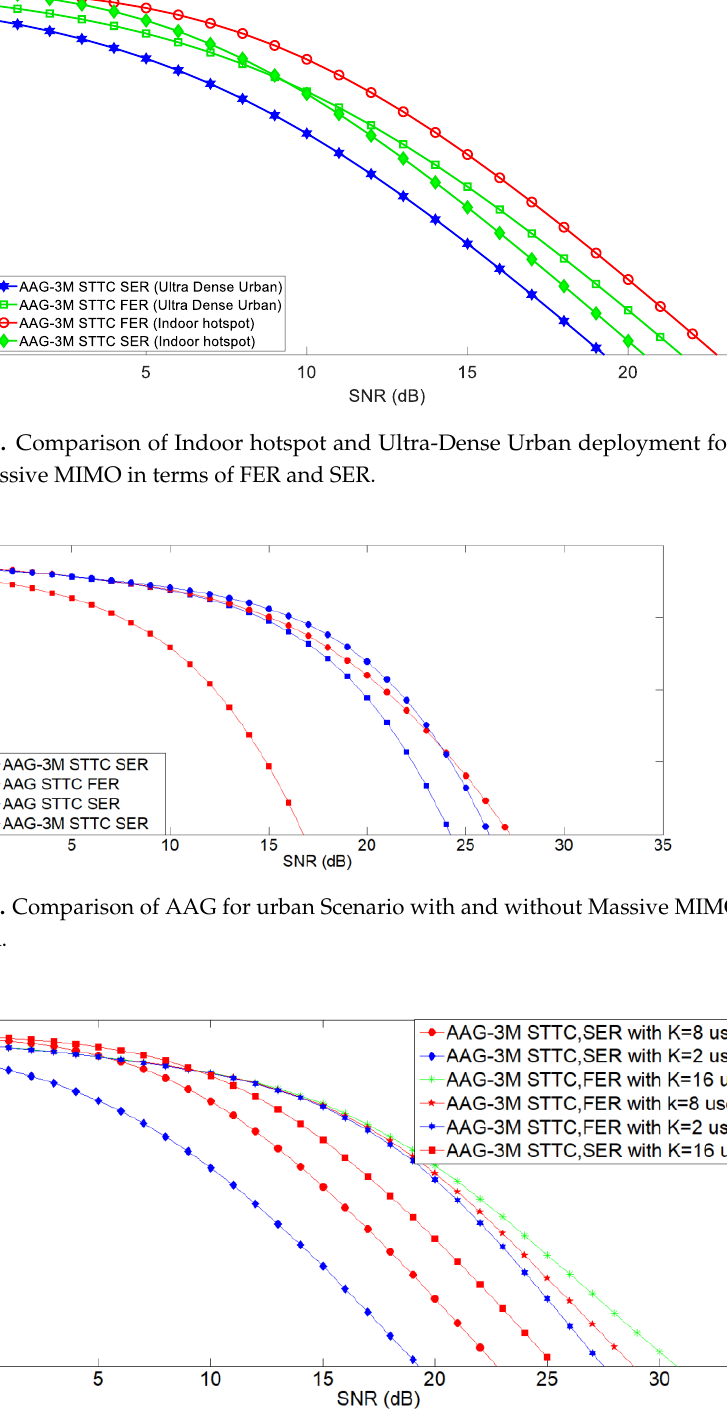
Figure 7. Comparison of AAG-3M with different number of users in terms of SER and FER.